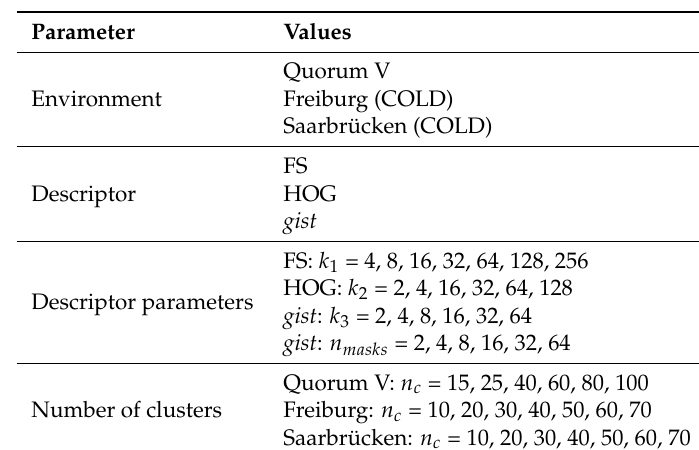
Table 2. Summary of the parameters that have been varied to carry out the clustering experiments. FS, Fourier